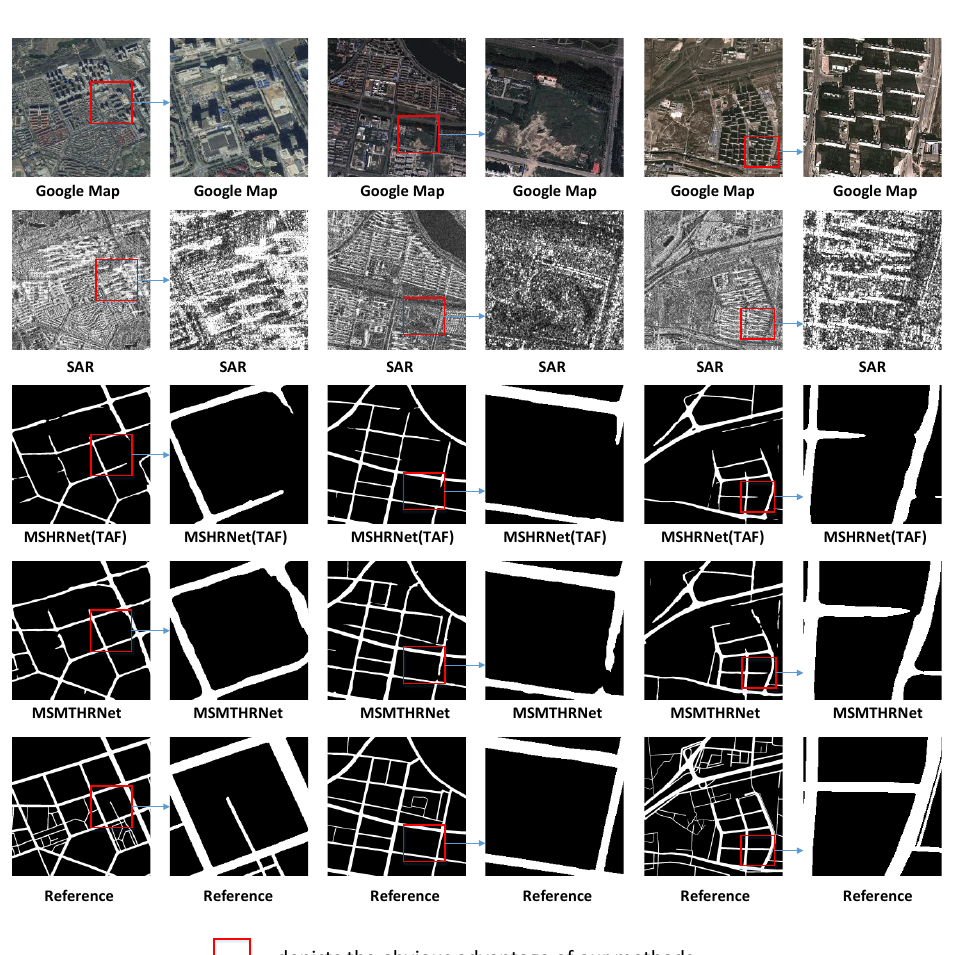
Figure 9. Qualitative comparison of road detection results produced by different methods based on three images from our test